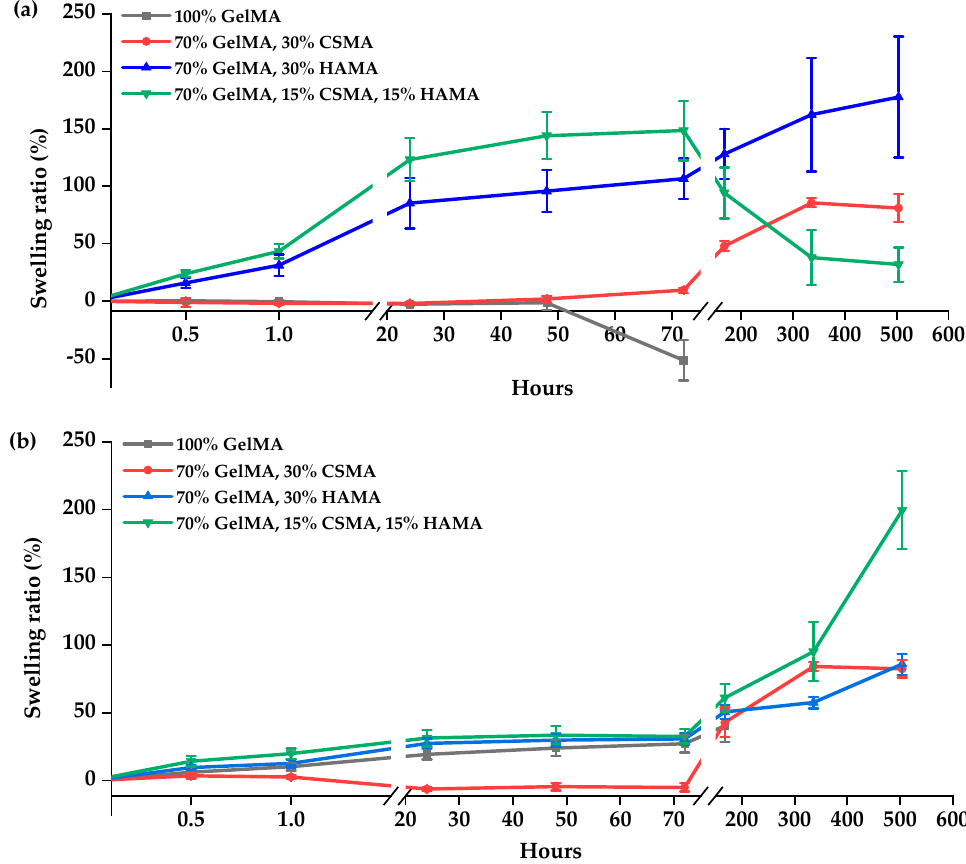
Figure 6. Swelling ratio (%) of hydrogels produced with ( a ) 10% ( w / v ) GelMA or; ( b ) 20% ( w / v ) GelMA upon incubation in PBS.